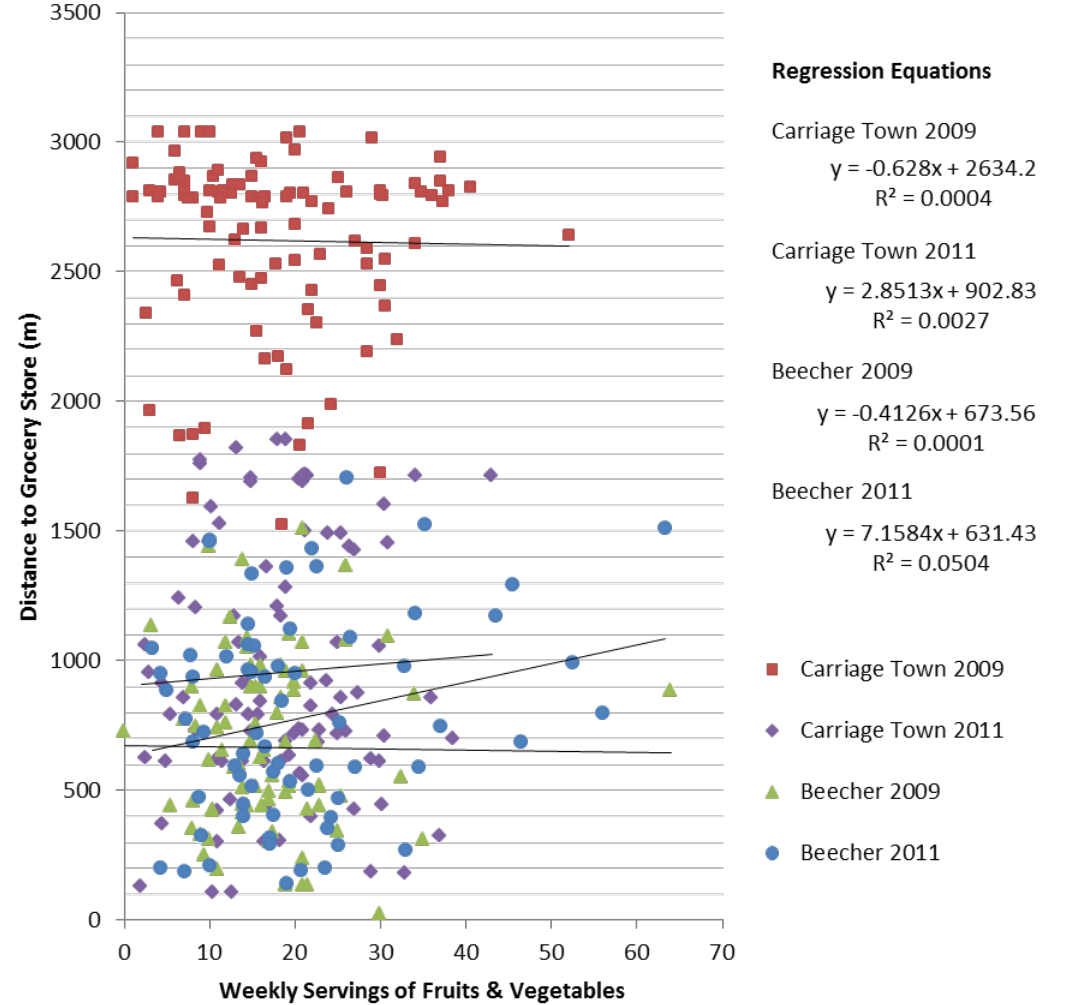
Figure 3. Regression lines for relationships between fruit and vegetable consumption and distance to a grocery store by